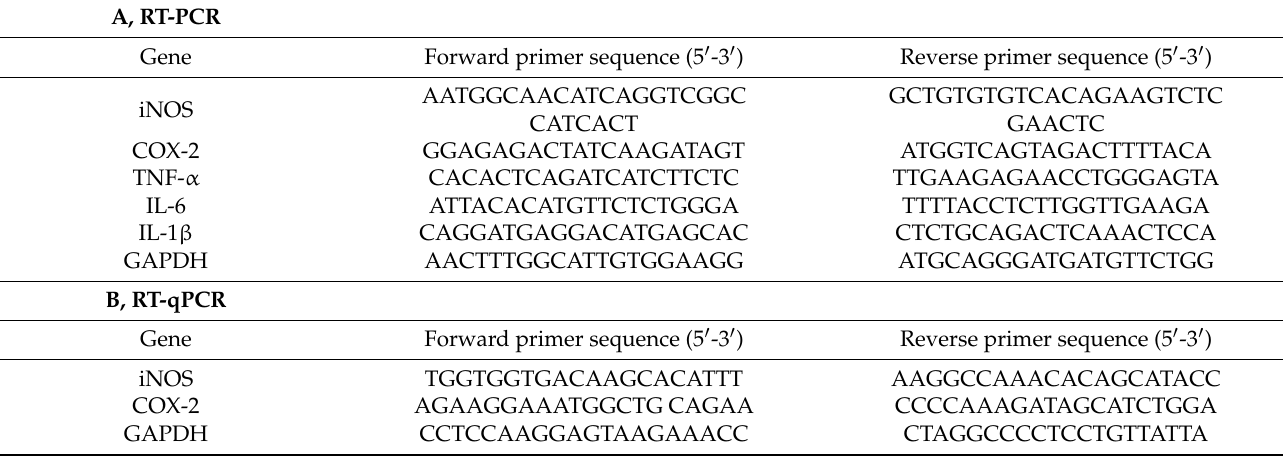
Table 1. Sequences of primers used in the RT-PCR and RT-qPCR